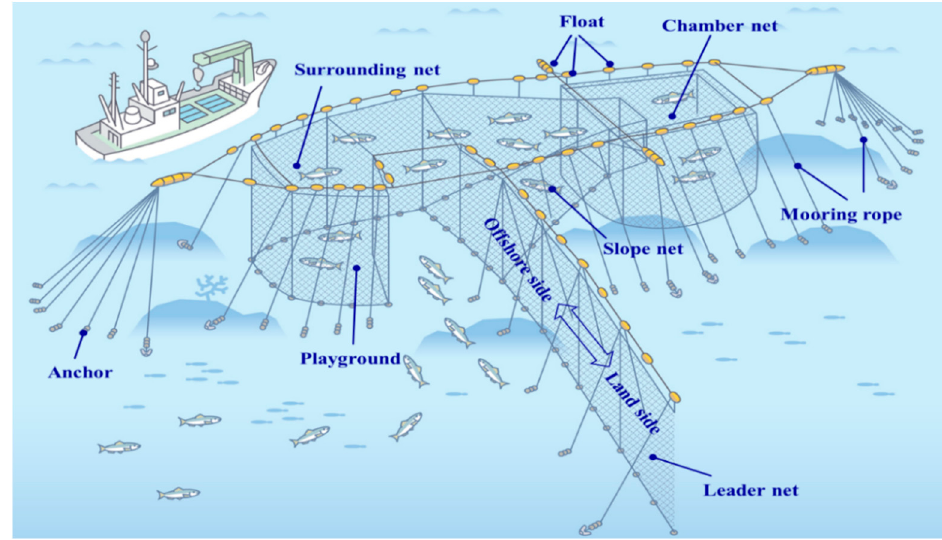
Figure 1. Structure of a set-net reproduced from [6].